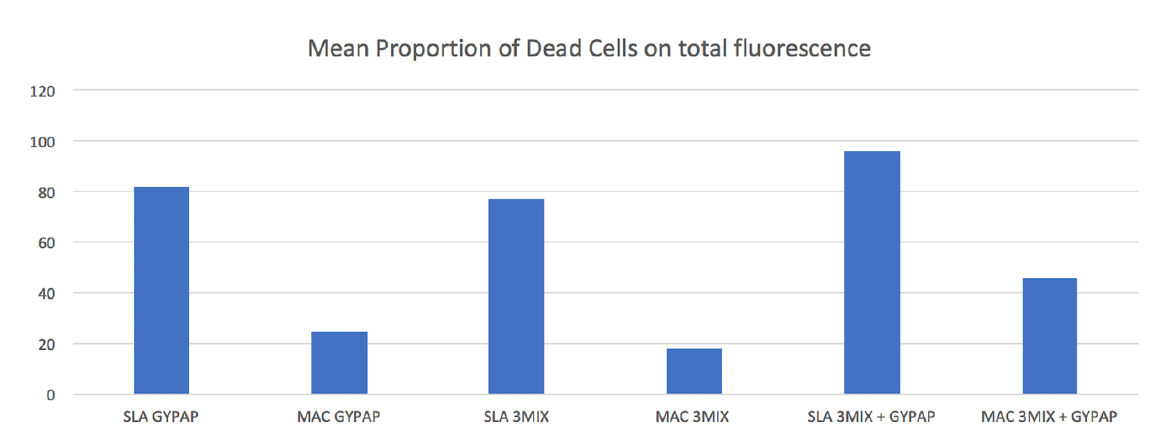
Figure 2. Confocal laser scanning microscopy (CLSM) images of the machined (MAC) and acid etched surface (SLA) titanium surfaces with two different decontamination protocols. The scale bar was set to 10 microns.